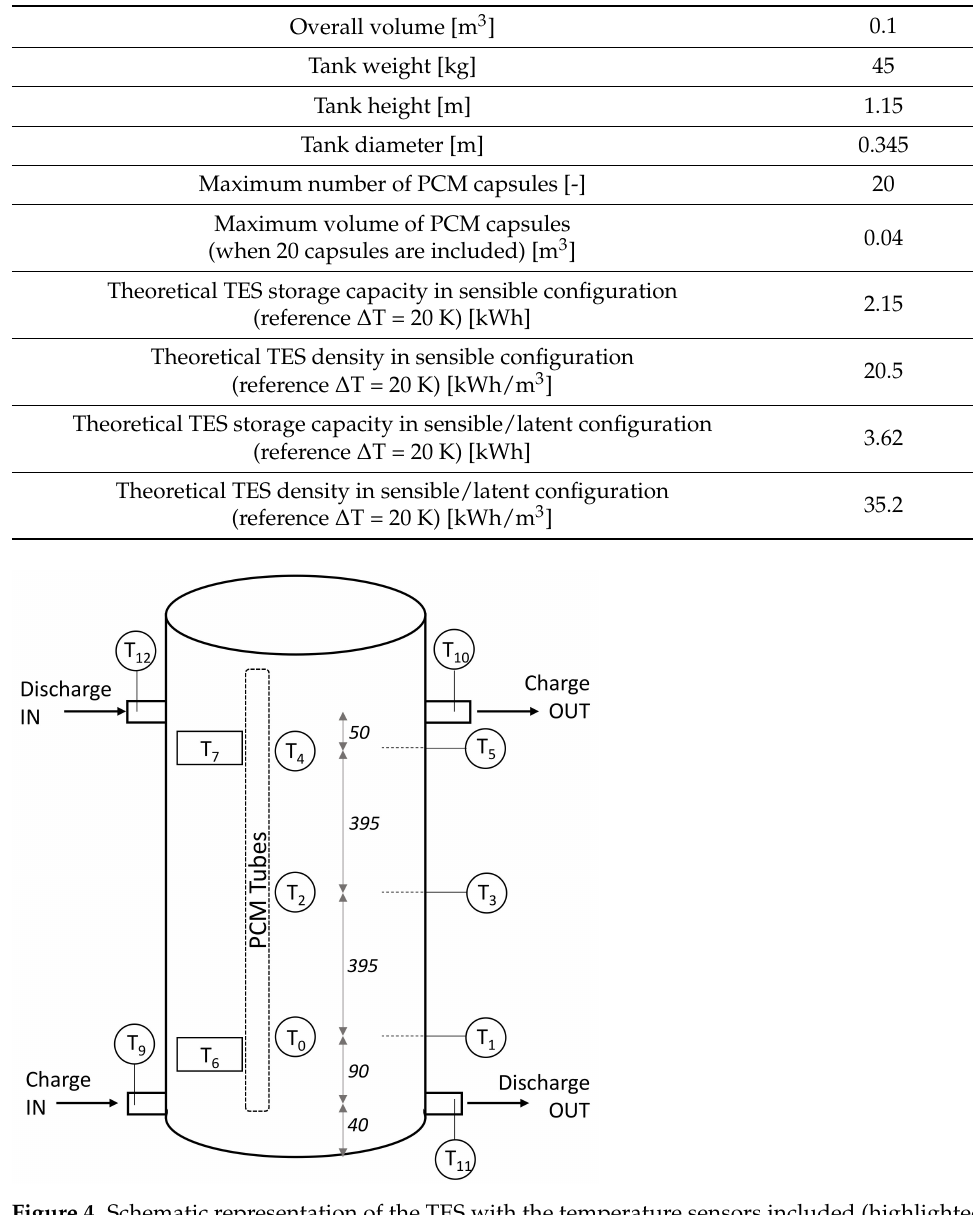
Table 2. Main features of the designed and manufactured sensible/latent TES.